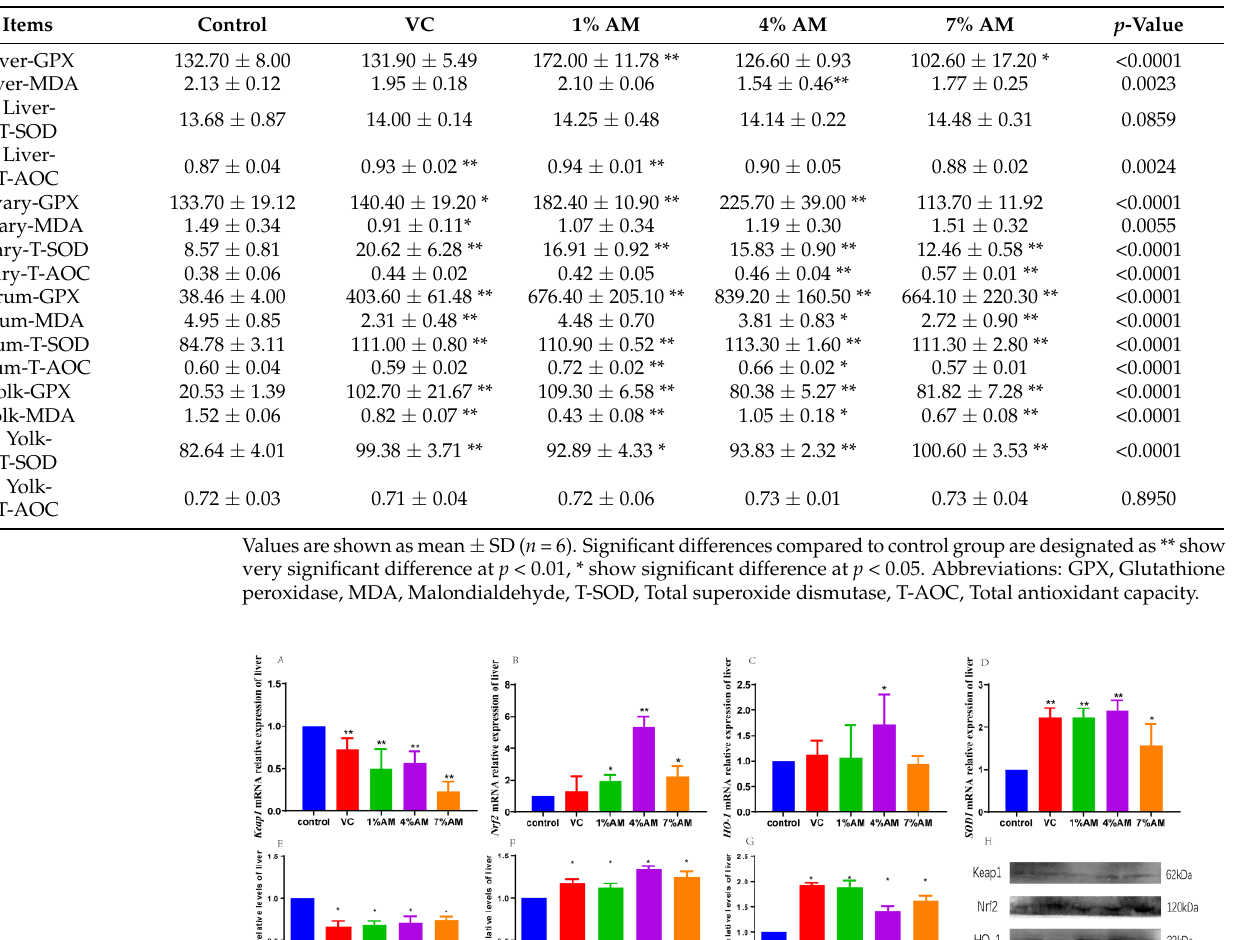
Table 2. Effects of feed supplemented with AM on antioxidant parameters.